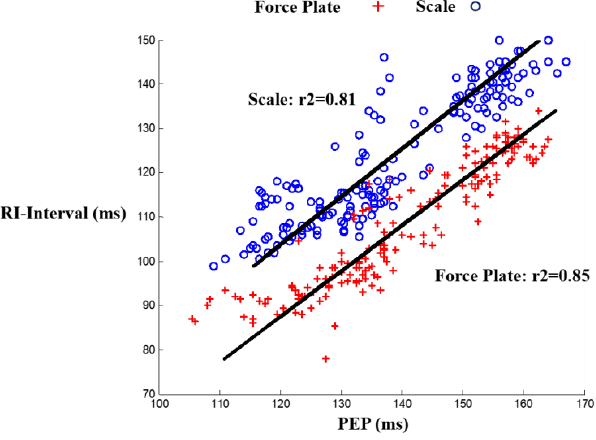
Figure 3. Linear regression fit for both scale and force plate head-to-foot BCG RI-interval vs. PEP among all subjects.